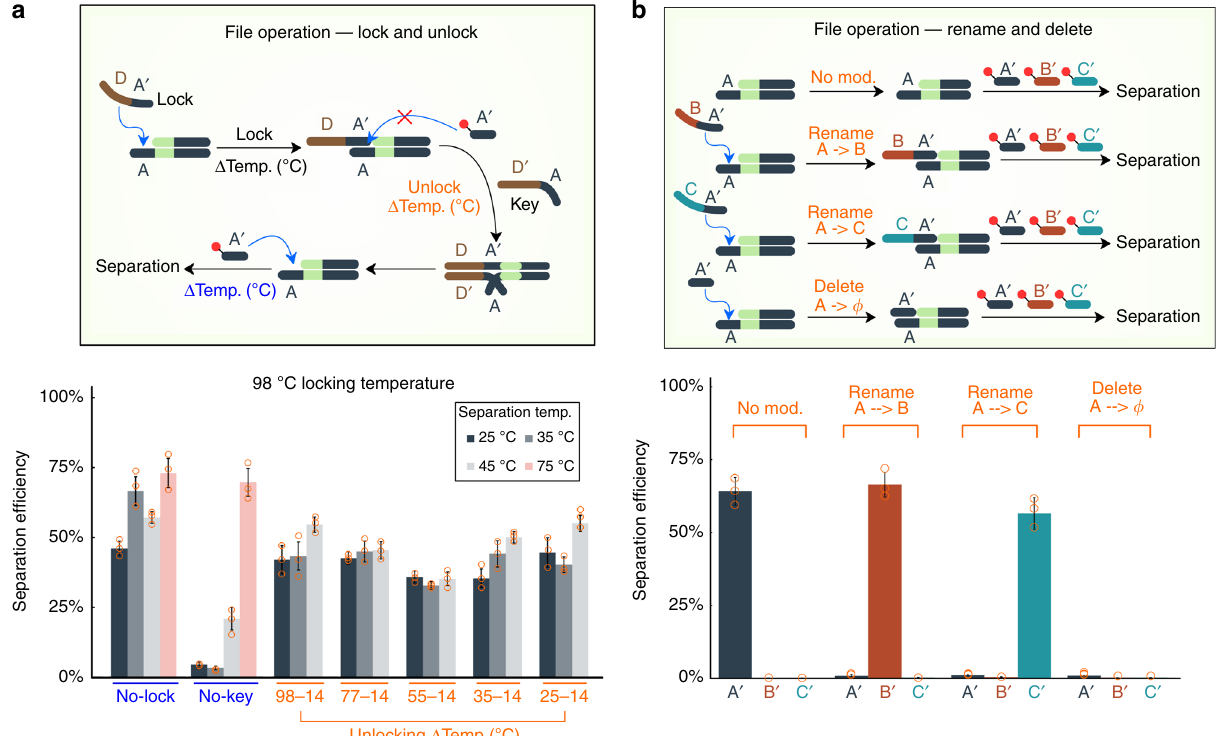
Fig. 6 Toeholds enable in-storage fi le operations. a (Top) Schematic of locking and unlocking in-storage fi le operations. (Bottom) Attempts to access fi le A by DORIS without locking (No-Lock), with locking but without a key (No-Key), or with locking and key added at different temperatures (orange) ( n = 3 for each condition). The lock was added at 98 °C. The key was added at different temperatures (orange) and then cooled to 14 °C ( n = 3 for each condition). Oligo A ’ was added at different access temperatures of 25, 35, 45, or 75 °C for 2 min, followed by a temperature drop of 1 °C/min to 25 °C ( n = 3 for each condition). Separation ef fi ciency is the amount of fi le A recovered relative to its original quantity, as measured by qPCR. b (Top) Schematic of rename and delete operations. File A was modi fi ed by renaming or deleting oligos. (Bottom) The completion of each operation was tested by measuring how much of the fi le was separated by each individual oligo: A ’ , B ’ , or C ’ . Separation ef fi ciency is the amount of fi le A separated relative to its original amount in the database, as measured by qPCR. No Mod (No fi le modi fi cation/operation). Plotted values represent the arithmetic mean, and error bars represent the s.d., of three independent replicate fi le operations/separations. Source data are provided as a Source Data fi